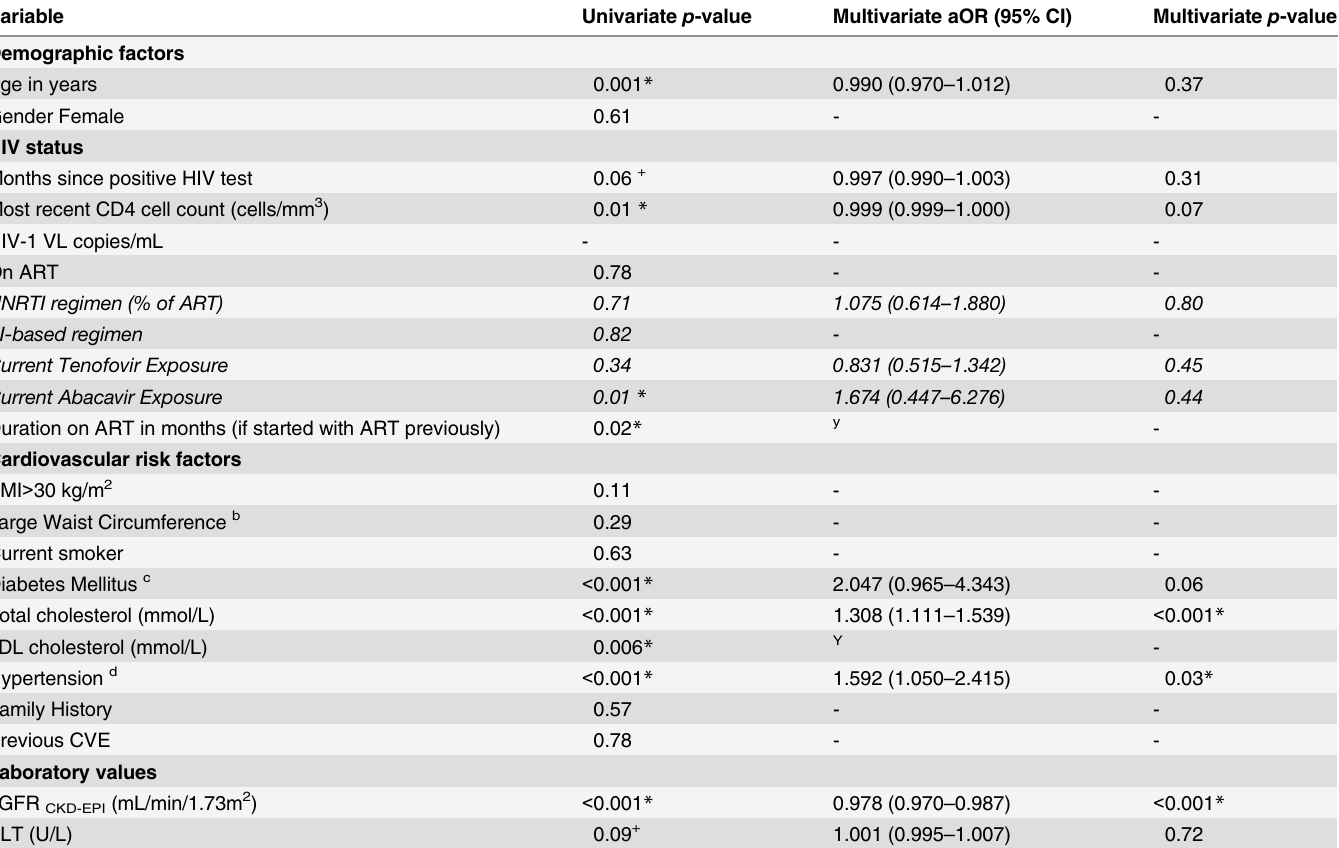
Table 2. Variables associated with albuminuria a in univariate and multivariate analysis in an unselected group of HIV-infected patients.